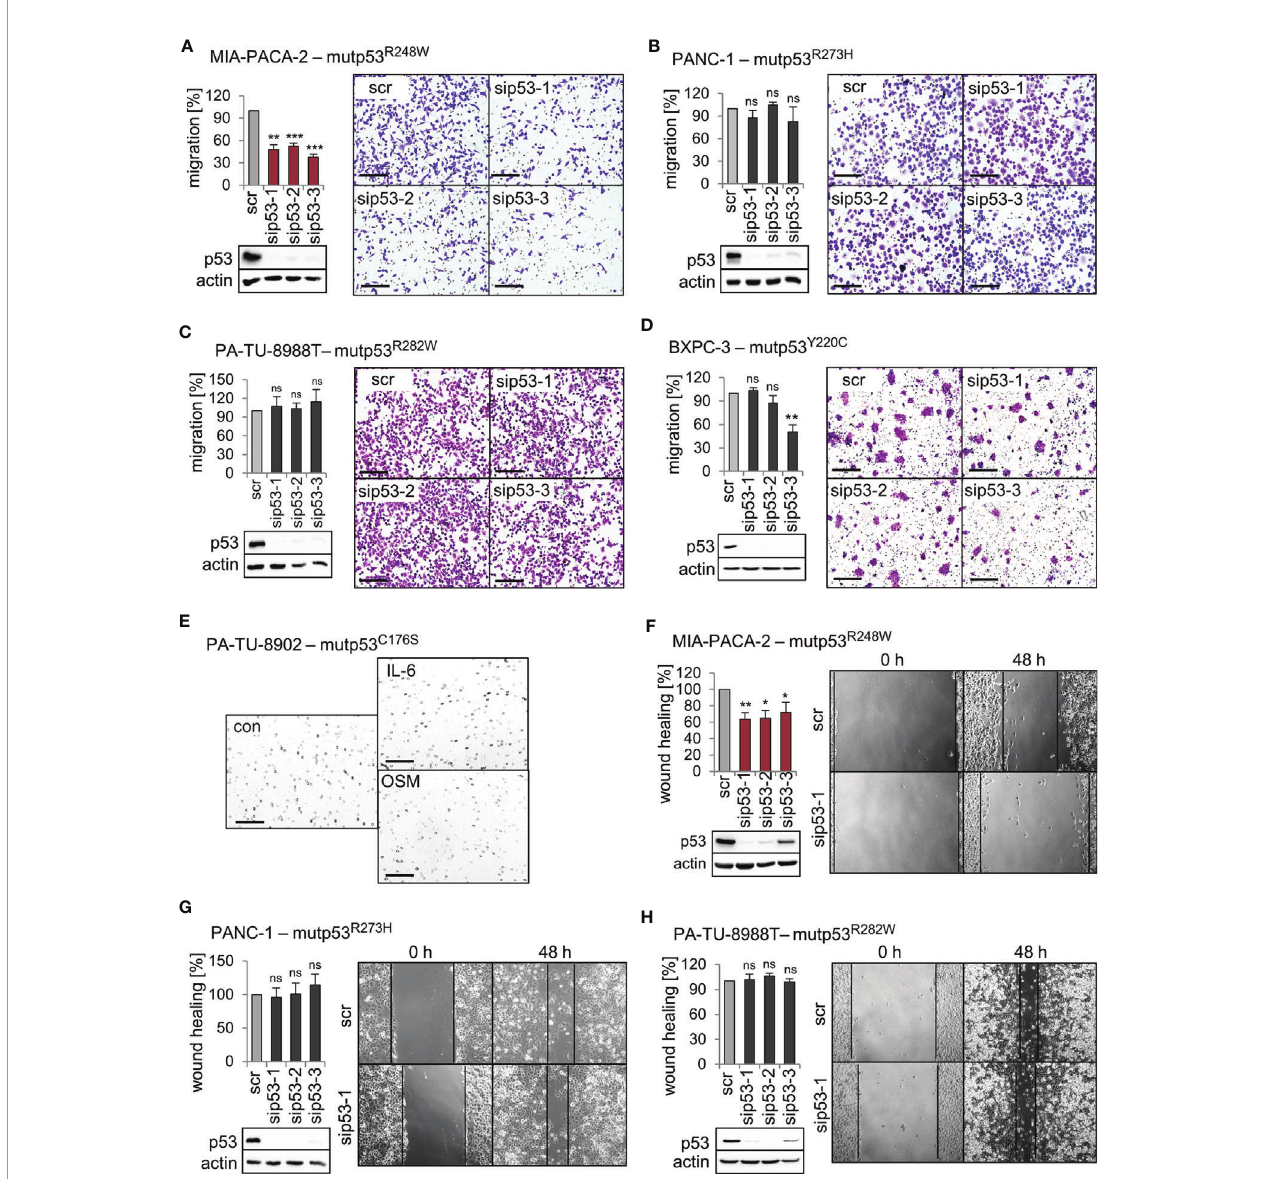
FIGURE 3 | Mutp53 R248W selectively promotes migration in PDAC cells. (A – D) Transwell migration assays of MIA-PACA-2, PANC-1, PA-TU-8988T, and BXPC-3 cells to evaluate mutp53-dependent migration activity. mutp53 was depleted with three different siRNAs against TP53 mRNA (sip53 1-3). Seventy-two hours post- transfection with siRNAs, cells were seeded into transwell inserts and migration to the membrane underside was determined after 24 h. MIA-PACA-2 cells: 3 biological replicates (n = 3), PANC-1 cells: 2 biological replicates (n = 2), PA-TU-8988T cells: 3 biological replicates (n = 3), BXPC-3 cells: 3 biological replicates, one with a technical replicate (n = 4). Note, siRNA ‘ sip53-3 ’ reduced migration in BXPC-3 cells might be a consequence of siRNA off-target effects. Migration was calculated relative to scrambled control (scr, set as 100%). Representative images of membrane undersides are shown. Scale bars, 200 µm. Immunoblot analysis veri fi es knockdown of mutp53. Actin, loading control. (E) Transwell migration assay of PA-TU-8902. Representative images of stained transwells after 24 h of migration are shown. To induce migration, cells had been stimulated for 24 h with 50 ng/mL Interleukin-6 (IL-6), Oncostatin M (OSM), or solvent control (con) prior to seeding into inserts, followed by additional cytokine treatment for another 24 h. Gray dots are pores of the membrane. Scale bars, 200 µm. (F – H) mutp53- dependent wound healing of MIA-PACA-2, PANC-1, and PA-TU-8988T cells. mutp53 knockdown for 48 h using three different siRNAs (sip53 1-3). Forty-eight hours post-transfection, scratch assays were performed for another 48 h. A minimum of fi ve images were taken and quanti fi ed. MIA-PACA-2 cells: 3 biological replicates, 1 out of 3 with a technical replicate (n = 4), PANC-1 cells: 2 biological replicates, 1 out of 2 with a technical replicate (n = 3), PA-TU-8988T cells: 2 technical replicates (n = 2). Wound healing capacity was calculated relative to scrambled control (scr). Representative images after 0 h and 48 h are shown. Solid lines represent edges of the scratch. Immunoblots verify knockdown of mutp53. Actin, loading control. (A – D, F – H) Diagrams represent the means ± SEM. Student ’ s t test. *p ≤ 0.05; **p ≤ 0.01; ***p ≤ 0.001; ns, not signi fi